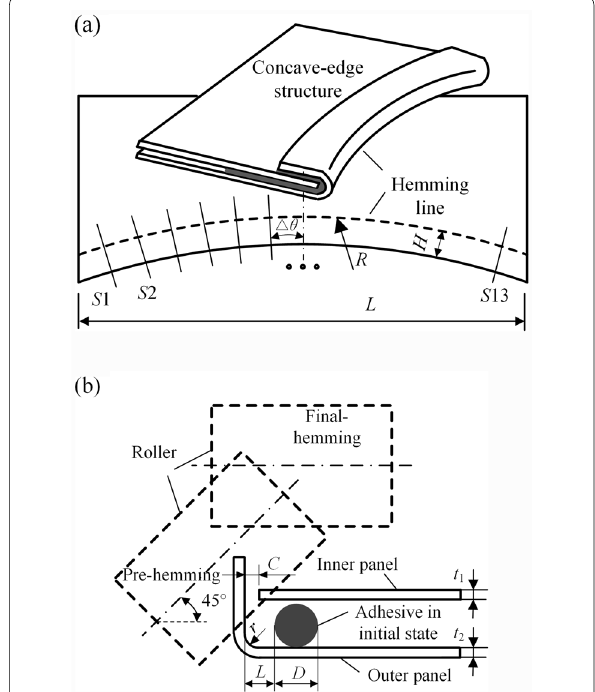
Figure 6 Schematic diagram of sample geometry: (a) Planar structure with concave edges, (b) Initial state of adhesive in the cross section